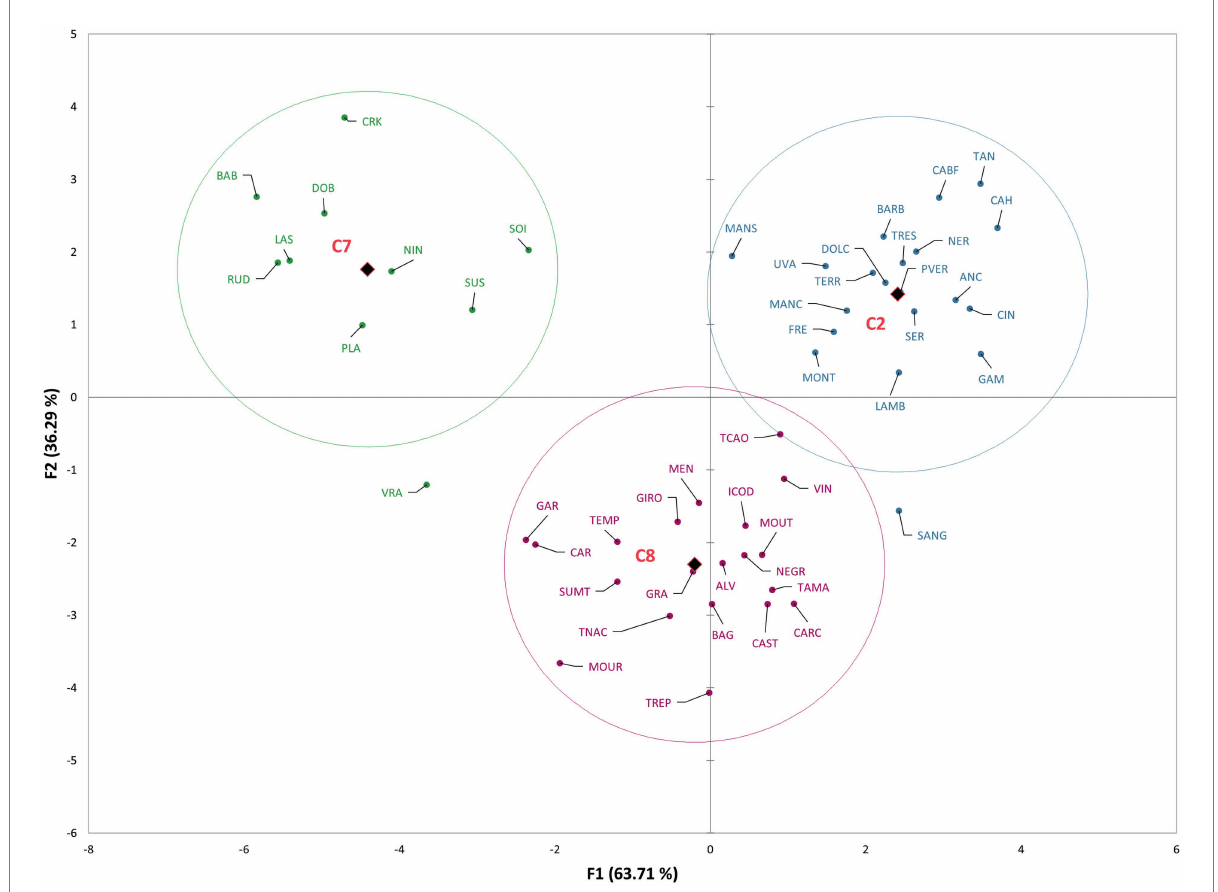
FIGURE 3 The scatter plot of discriminant analysis representing cultivars from different GEN-GEO